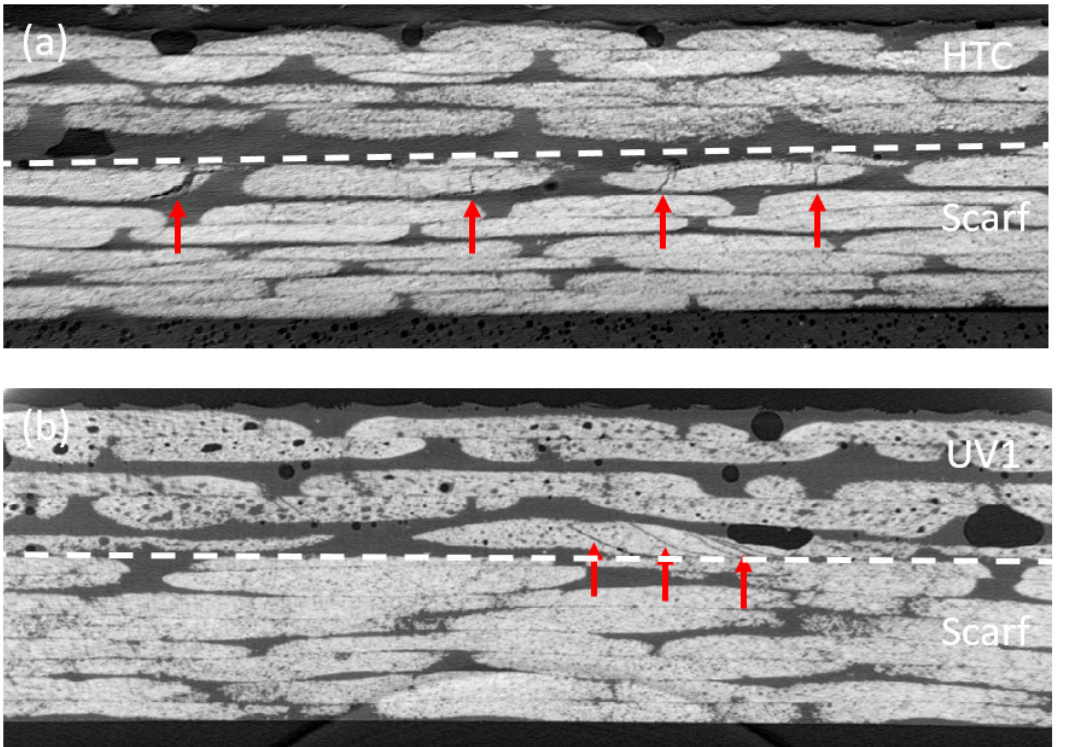
Figure 13. Cracks identified in samples ( a ) HTC and ( b ) UV1. The white dotted line indicates the interface between the scarf and the repair, and the red arrows indicate cracks.